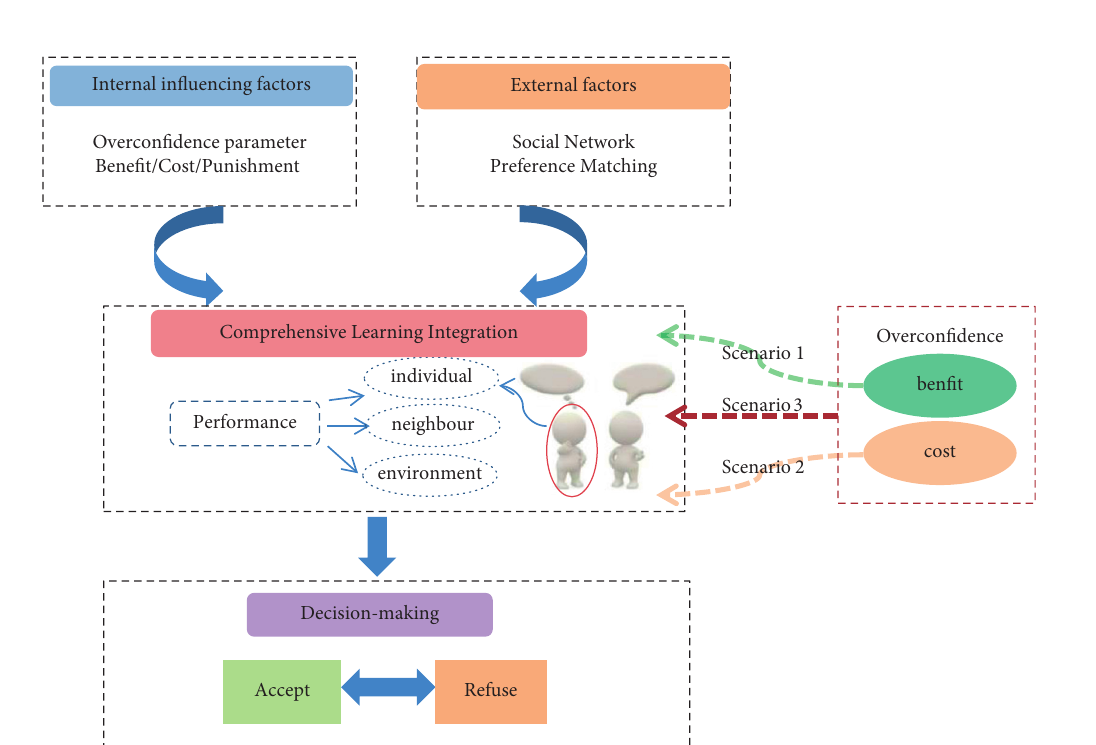
Figure 2: Conceptual model of individual decision-making behavior.